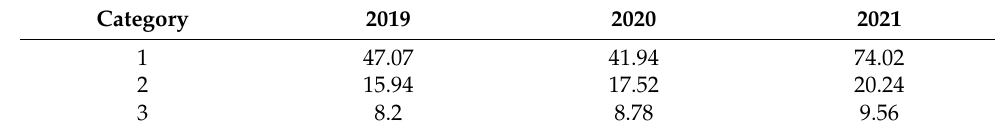
Table 4. The number of attempted suicides per 100,000 men